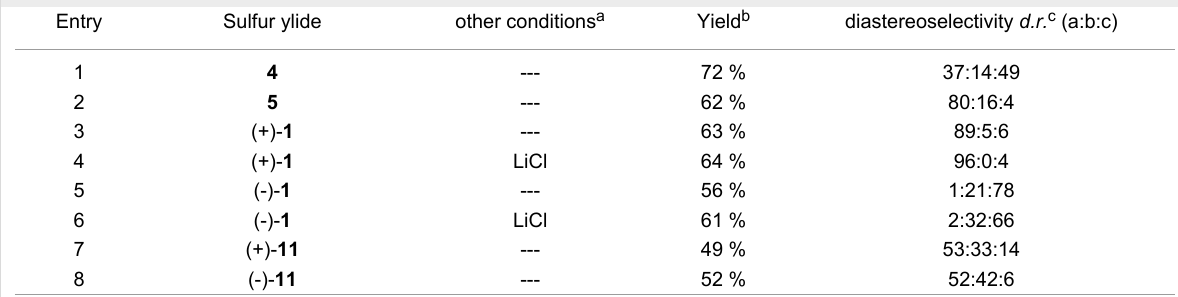
Table 1: Epoxidation of (+)-Glyceraldehyde with Sulfur